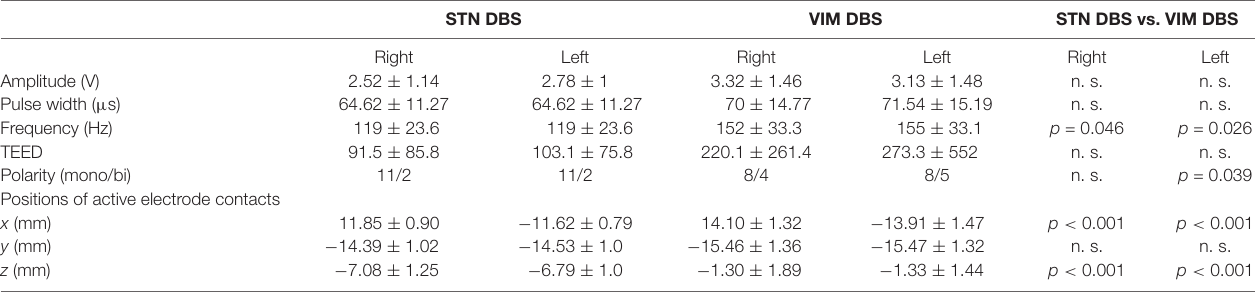
TABLE 2 | Deep Brain Stimulation (DBS)